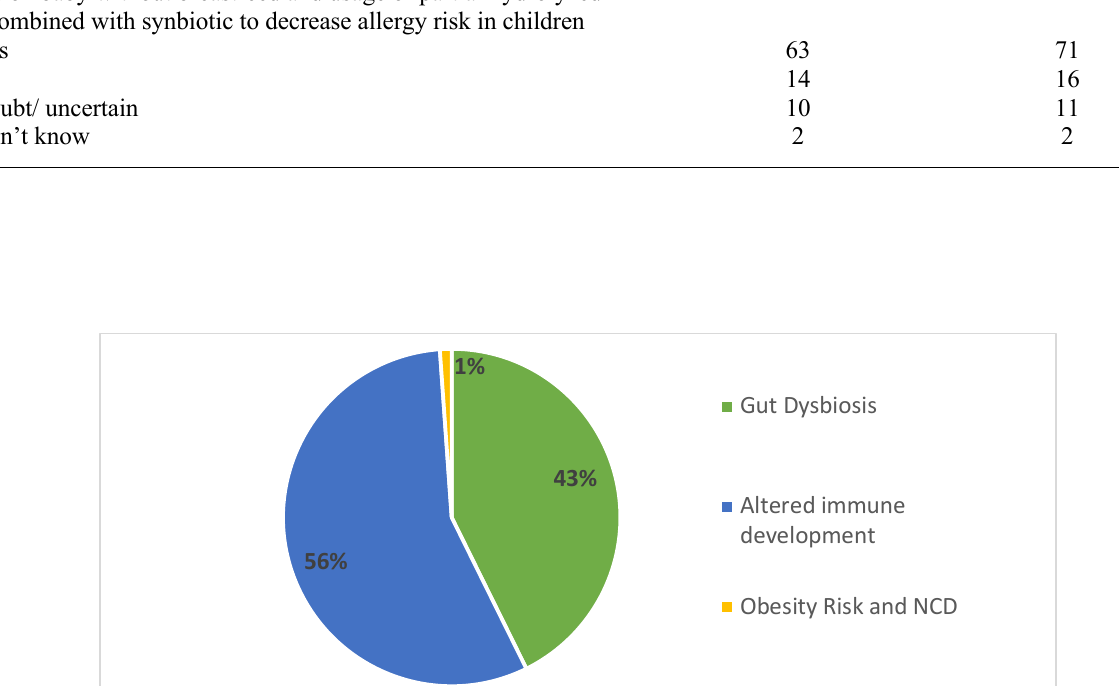
Figure 1. Knowledge of health risk of children with C-section history